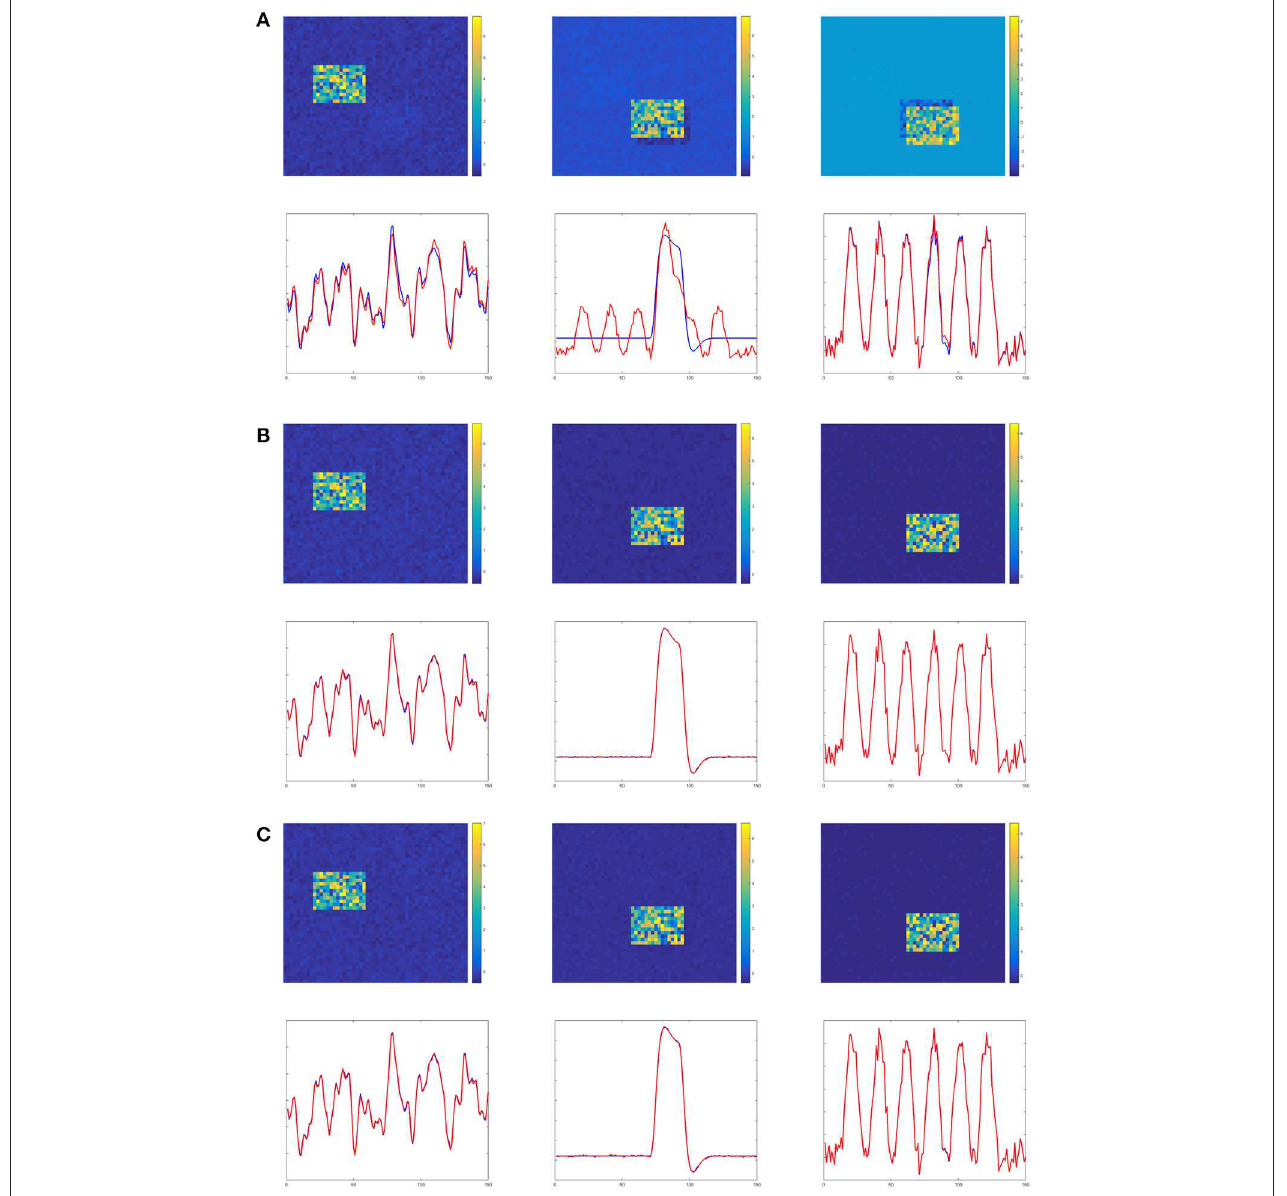
FIGURE 5 | Experiment B in the case of low noise, high overlapping and low collinearity. It shows TPICA suffers from the overlapping issue. (A) TPICA. (B) PARAFAC. (C) Proposed Non-Gaussian penalized